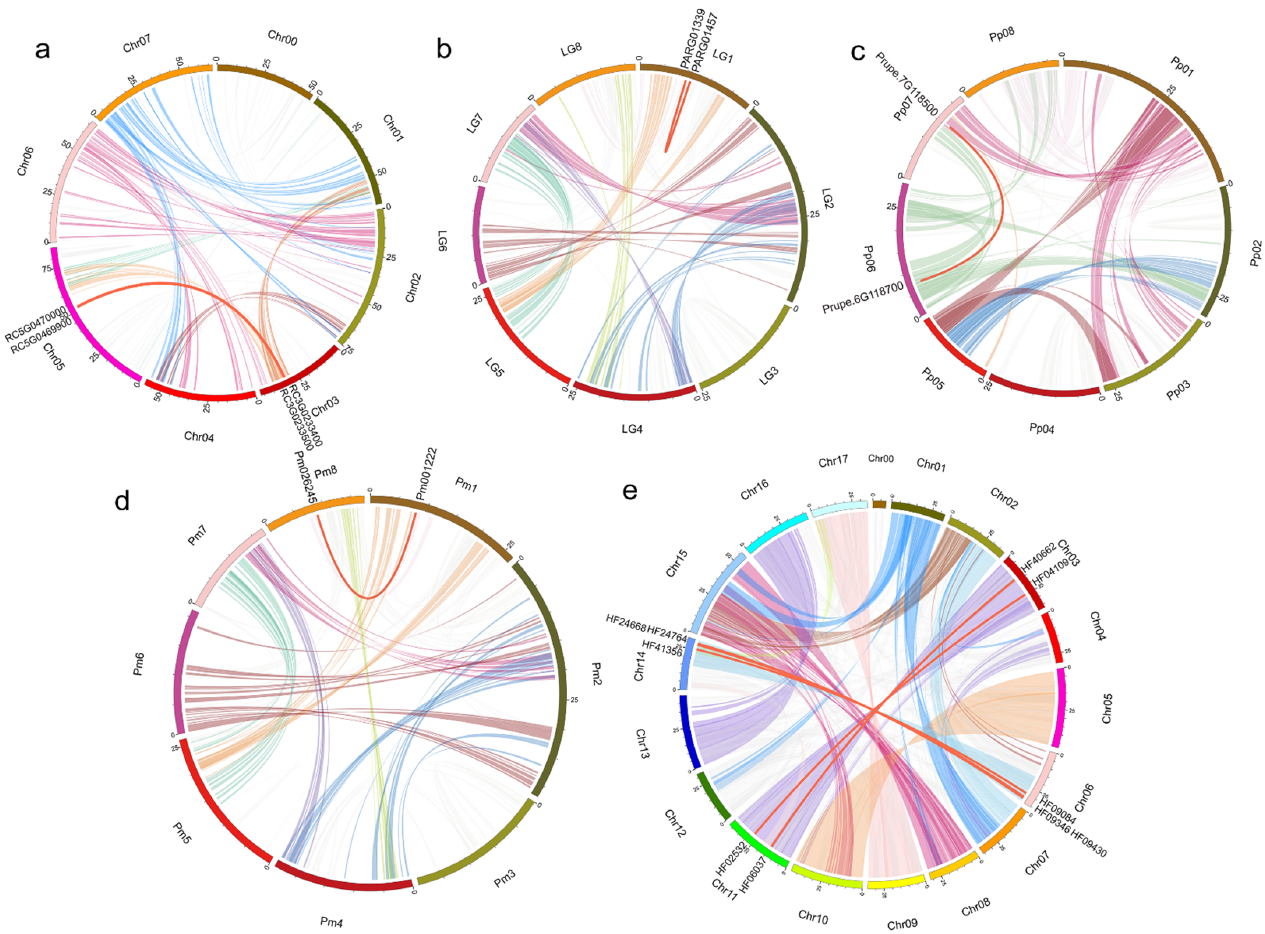
Figure 5. Collinearity of segmental duplication gene pairs of HDACs in five Rosaceae species. ( a ) R. chinensis ( b ) P. armeniaca ( c ) P. persica ( d ) P. mume ( e ) M. domestica . The red lines represent the segment duplication (SD) gene pairs of the HDACs .